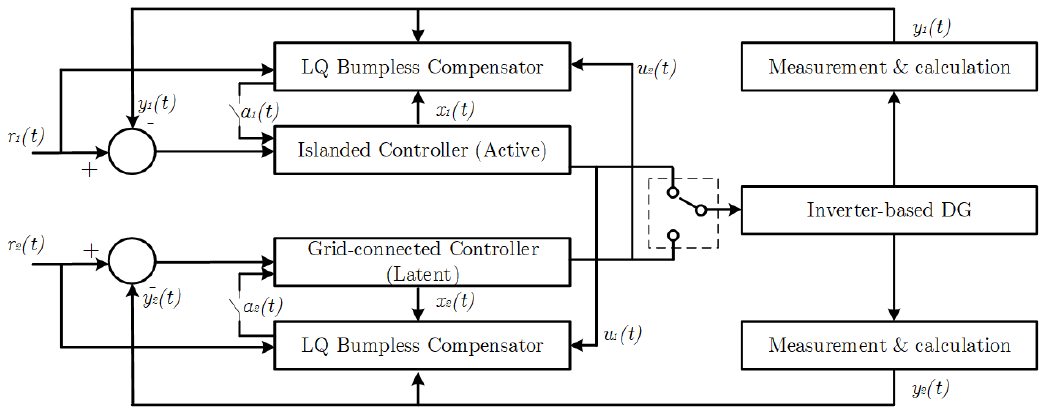
Figure 9. Bumpless control structure of MGs with two mode controllers